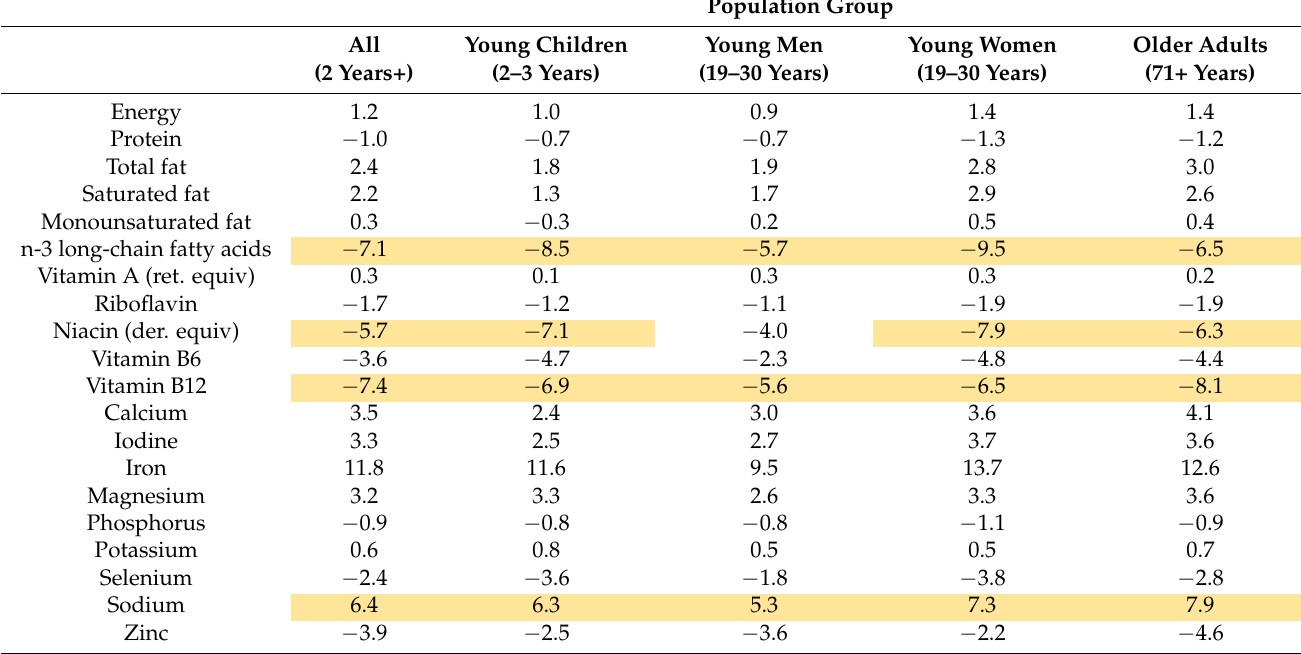
Table 5. Estimated percentage change 1 in mean daily intake of ‘Key Nutrients’ if ≈ 42 g per person per day of ‘Easily Swappable Animal-Source Meat’ is replaced with plant-based ‘meat’ (Accelerated Meat Scenario).